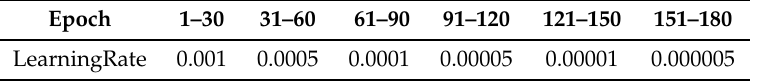
Table 1. Setting of the learning